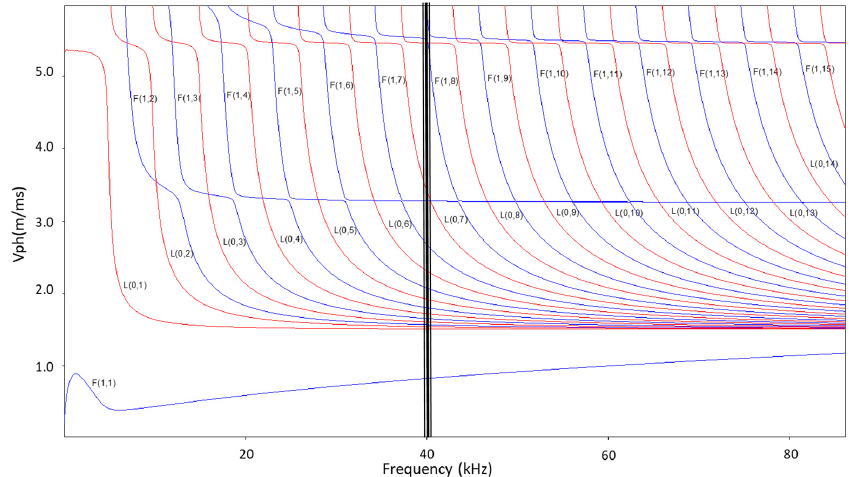
Figure 1. Phase velocity dispersion curve of a steel tube 2 mm × 270 mm diameter mm loaded with water.